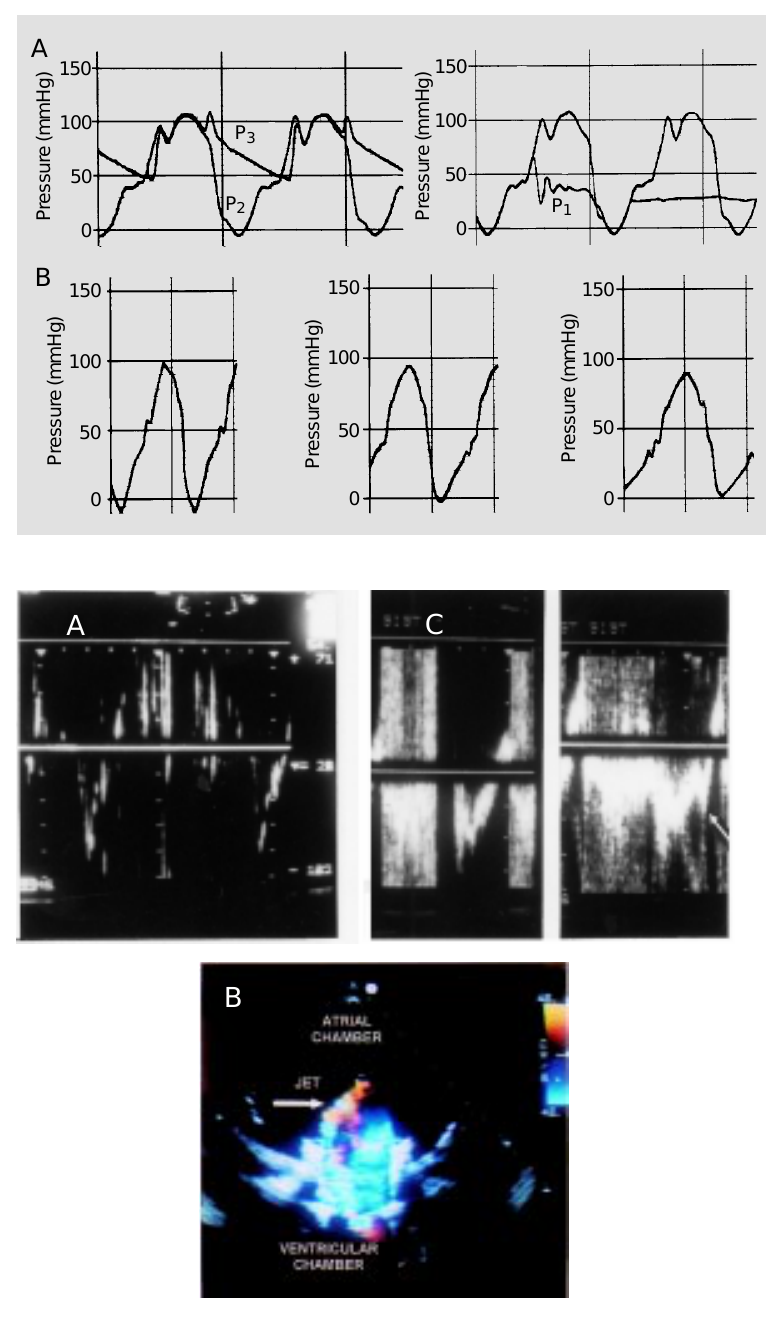
Figure 3 - Panel A , Pulsed Doppler velocities recorded at the outflow of the “ventricular” chamber showing a flow profile similar to that observed in the human left ventricular outflow tract. Panel B , Regurgitant jet as documented by color Doppler flow mapping in a biological prosthetic valve positioned at the “ventricular” inflow level. Panel C , Pulsed Doppler velocities recorded at the inflow of the “ventricular” chamber showing aliasing related to the regurgitant jet (produced in a biological prosthetic valve) and the inflow velocities without (left) and with (right) simulation of “atrial” contraction (arrow represents velocities related to “atrial